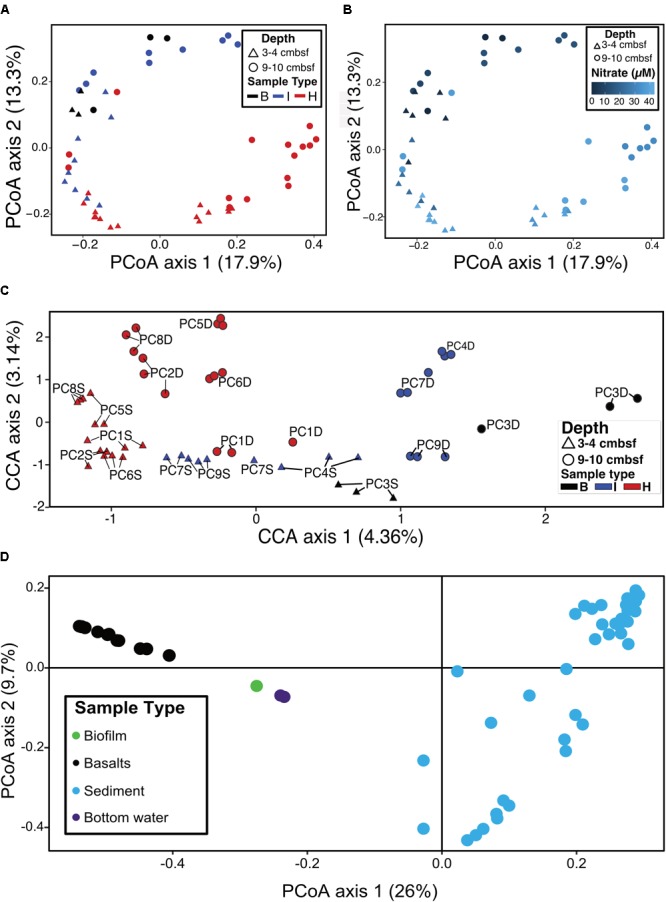
(A) Principal coordinates analysis (PCoA) of log transformed ASV abundance data showing clustering of samples by similarity using the Bray–Curtis dissimilarity index based on rank abundance, with points (samples) colored by sample type. (B) PCoA as in (A), with color coded by nitrate concentration. (C) Canonical correspondence analysis (CCA) of samples based on Bray–Curtis dissimilarity index using log-transformed ASV frequencies, nitrate concentrations, and solid phase manganese concentrations. Labels show the core number (PC#), D indicates a deep sample (9–10 cmbsf) and S indicates a shallow sample (3–4 cmbsf). (D) PCoA of sediments (this study) and basalts, basaltic biofilm, and seawater samples (Lee et al., 2015).